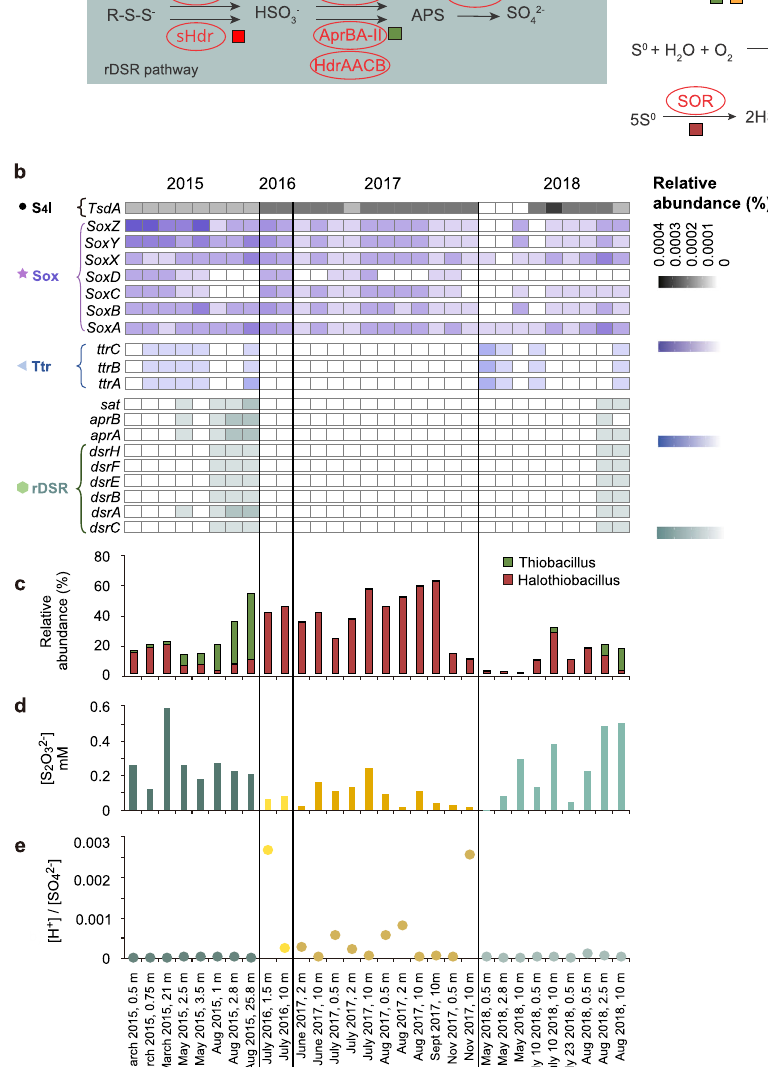
sulfur oxidative pathway gene distributions ( TsdA , soxABCDXYZ, ttrABC dsrABEFH , a prAB and sat.) . c Relative abundances of Halothiobacillus (complete Sox pathway genes) and Thiobacillus (incomplete Sox and rDSR pathway genes). d The dis- tribution of S 2 O 3 2 − . e [H + ]/[SO 4 2 − ] ratios from 2015 to 2018 in the tailings